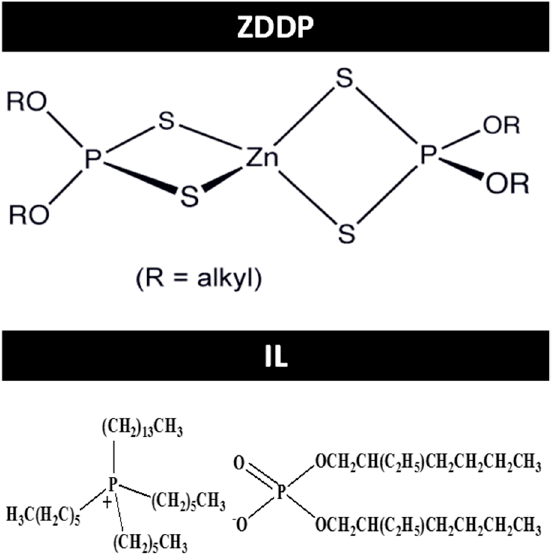
Figure 1. Molecular structures of ZDDP and IL.